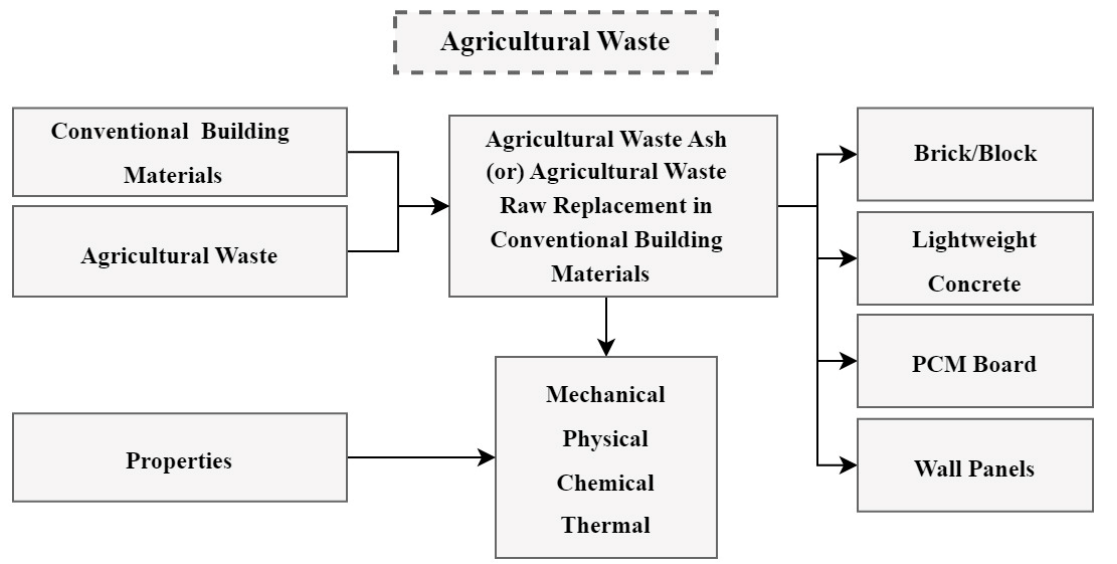
Figure 8. Applications of agricultural wastes as building materials.